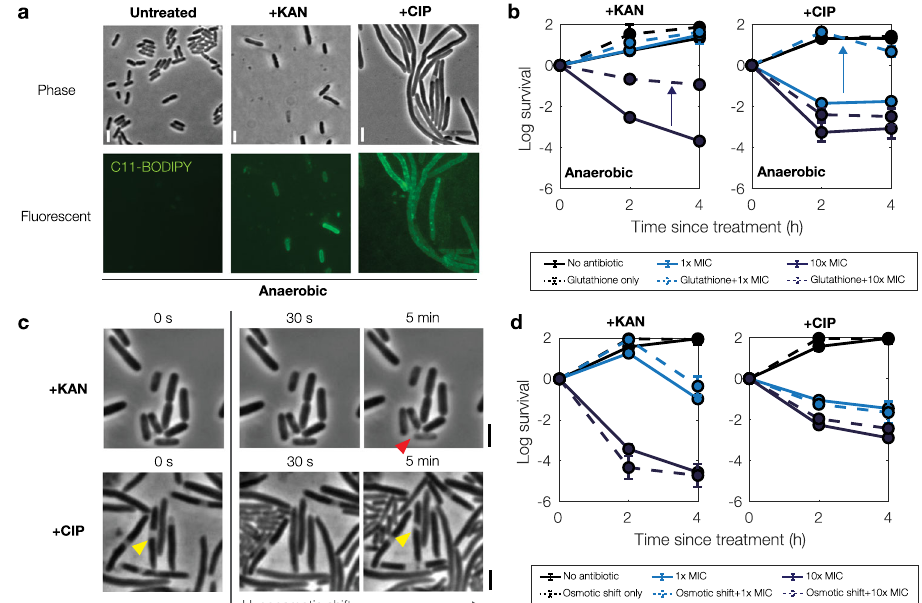
Fig. 7 Cytoplasmic condensation and antibiotic killing are robust to changes in oxygen availability and external osmolarity. a Phase-contrast and fl uorescence microscopy images of control and antibiotic-treated E. coli (10× MIC) taken 3 h after treatment. Cells were grown, treated, and imaged under anaerobic conditions in LB medium. Scale bar, 3 μ m. b Survival curves of E. coli under anaerobic kanamycin and cipro fl oxacin treatment, as determined by CFU plating and counting. Each point represents two biological replicates, error bars indicate one standard deviation, and data are presented as mean ± SEM. Positive values indicate increases in CFU/mL. Arrows highlight protection. All MICs used were with respect to their baseline values under aerobic conditions (Supplementary Table 1). c , d Same as ( a , b ), but for aerobic cell cultures that are hypoosmotically shocked by downshifting from 250 mM sorbitol after ~3 h of antibiotic treatment ( c ) and at plating ( d ). Yellow and red markers highlight condensed and lysed cells,